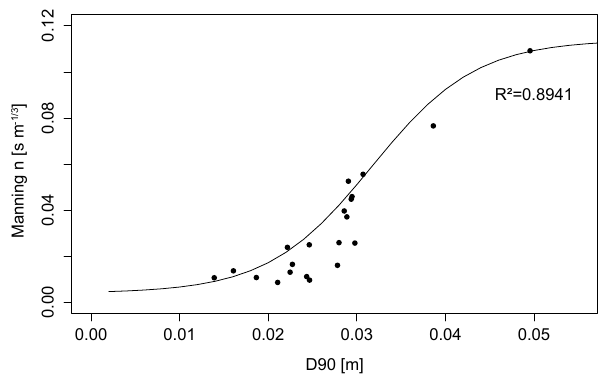
Figure 7. Comparison of D 90 values derived from SfM data and the Manning’s n resulting from tracer experiments. A sigmoid function distinctly increases the coefficient of